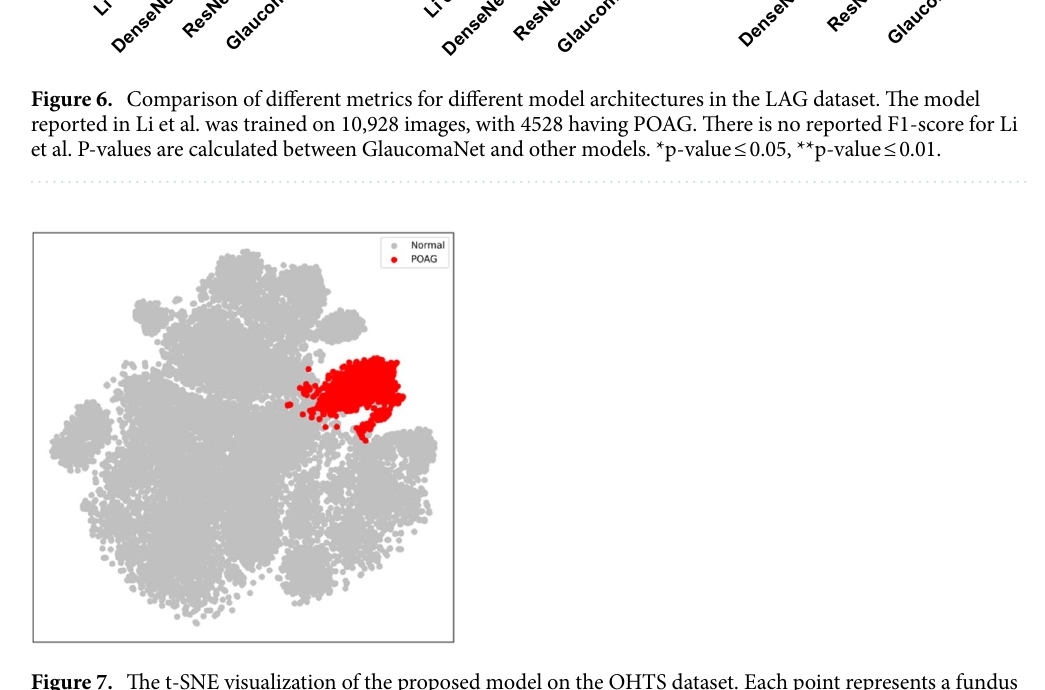
Figure 7. The t-SNE visualization of the proposed model on the OHTS dataset. Each point represents a fundus image. Red and gray dots represent the glaucomatous and non-glaucomatous